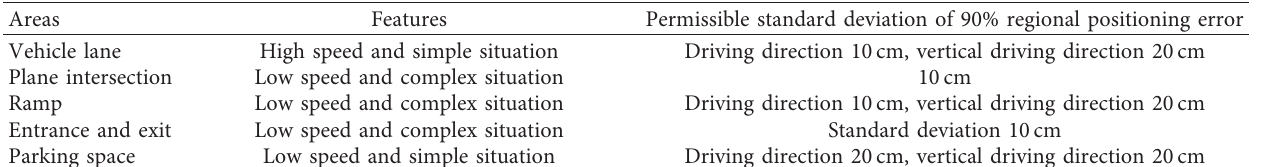
Table 4: Accuracy requirements of location in parking lot area.